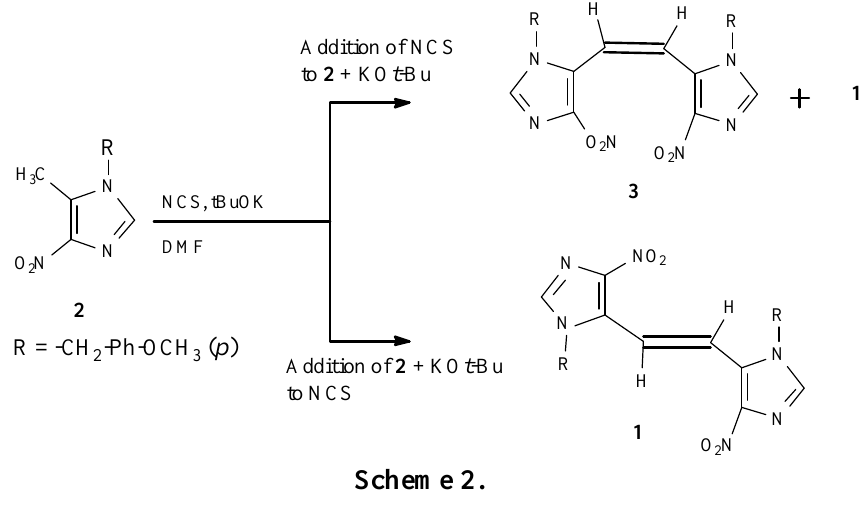
Figure 2. The UV absorbance spectrum of the mixture of 1 and 3 in chloroform: 8